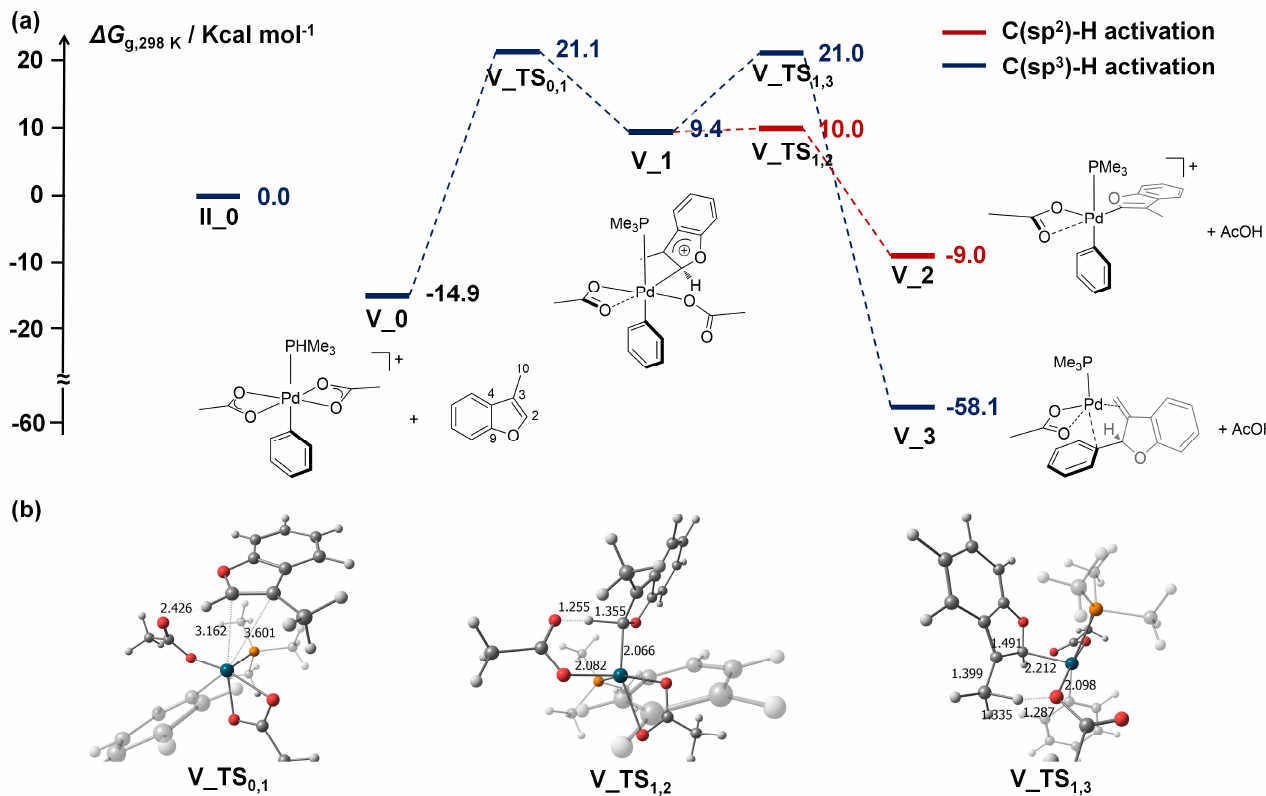
Figure 6. ( a ) Free energy reaction profile for C(sp 2 ) − H (red) and C(sp 3 ) − H (blue) activation by V . Numbers are Δ G in water at 298 °C (energies in kcal/mol). ( b ) Optimized geometries of transition states with selected bond lengths (Å). The phenyl and trimethylphosphine groups are drawn translucent for clarity.